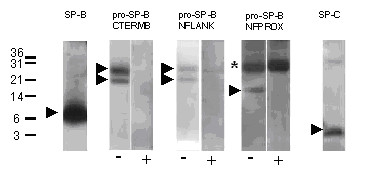
Children with pulmonary alveolar proteinosis. Western blotting of a lavage from patient PAP 12 (only NFPROX bands) and PAP 04 (all other bands) to demonstrate the most frequent abnormalities. After SDS-PAGE and transfer, the membranes were probed with the antibodies indicated. The pro-forms were probed in the absence (-) and presence (+) of an excess of the peptide used to raise this antibody. Note that bands that are not displaced by the competing peptide were not considered as specific bands and they are marked by an asterisk. The numbers next to the lanes indicate the molecular weights in kDa. The arrowheads indicate the abundance of SP-B, the bands at 19–21 and 25–26 kDa using CTERMB which also react with NFLANK, and some of the break-down fragments reacting with NFPROX which are more frequently seen in this condition and in cRD as compared to the other lung diseases (see figure 5). All bands were analyzed under reducing conditions.